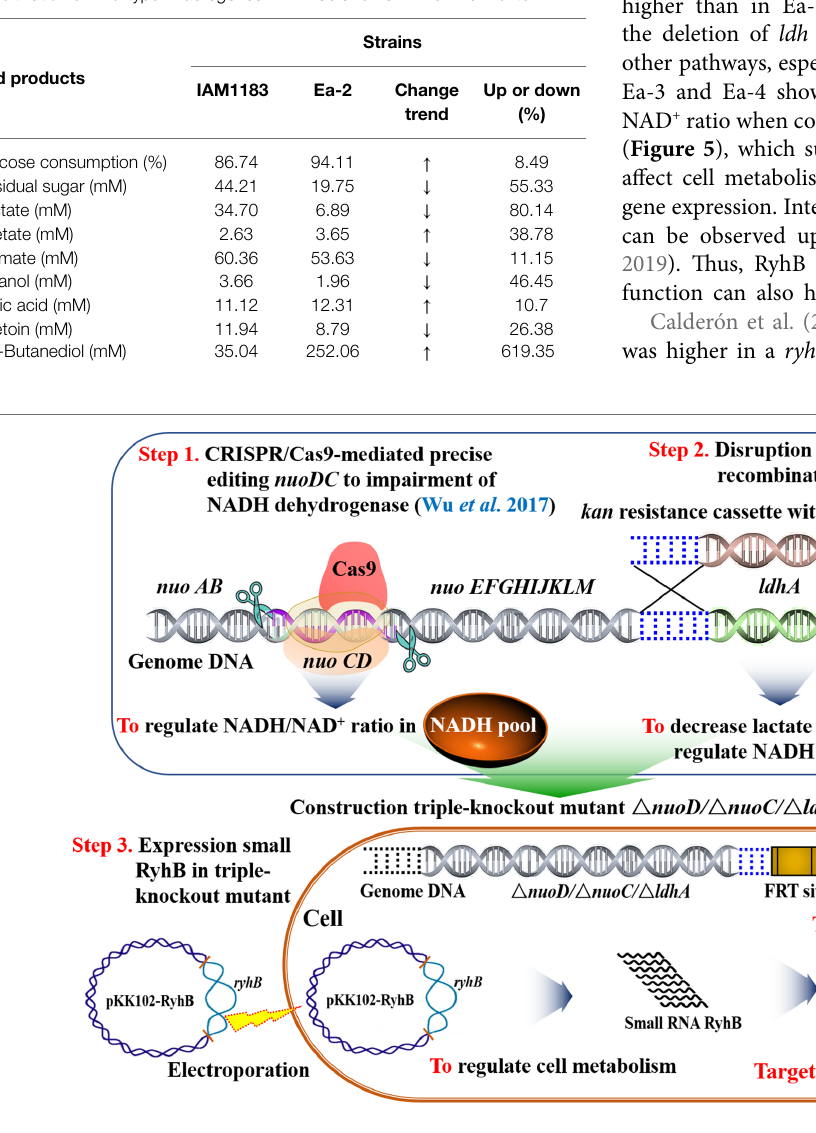
FIGURE 7 | Diagram of primary aerobic metabolic pathways for bacterial 2,3-BD production. Shown are three putative strategies to enhance 2,3-BD yield as outlined in this